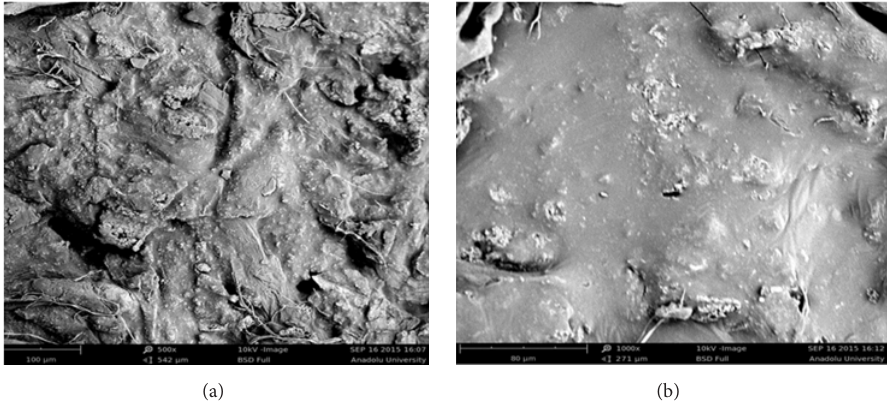
Figure 8: SEM images of PK-BTM30CW70 exposed to L-HW: (a) 500x; (b)